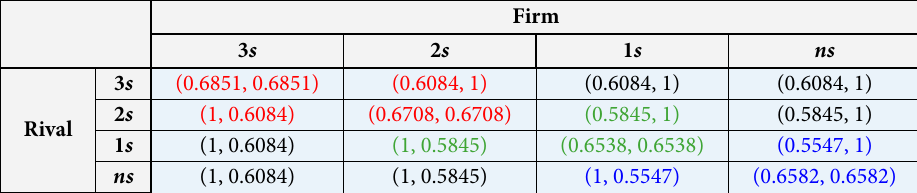
Table 7. Technological transition: four observations, risk-neutral DM, and signals on X 2